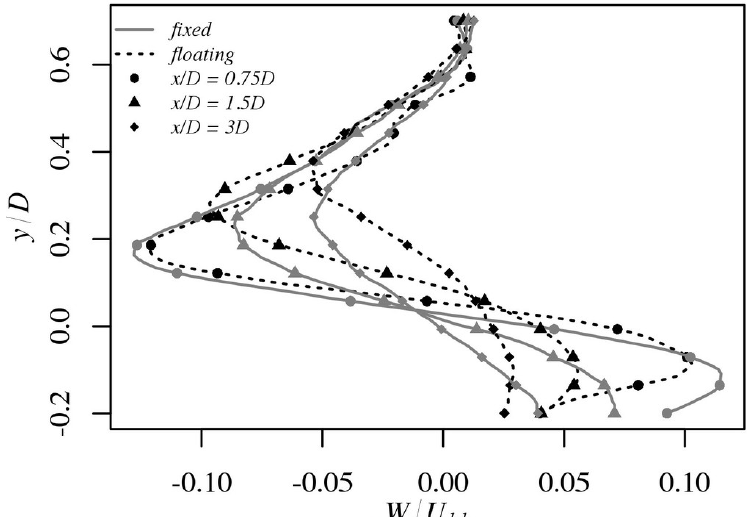
Figure 10. Near wake profiles of W/U distances 0.75 D , 1.5 D and 3 D .